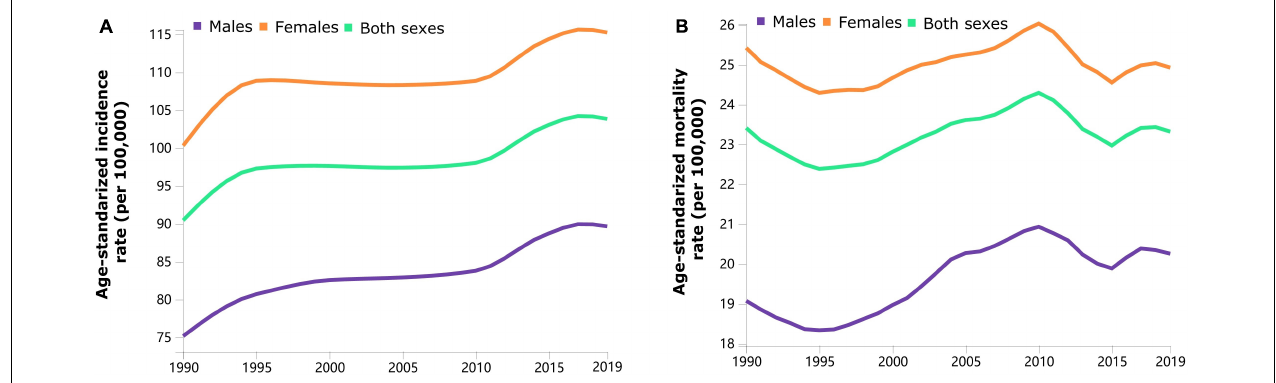
FIGURE 1 | Trends in the sex-specific age-standardized incidence (A) and mortality (B) rates for Alzheimer’s disease and other forms of dementia in China from 1990 to 2019.